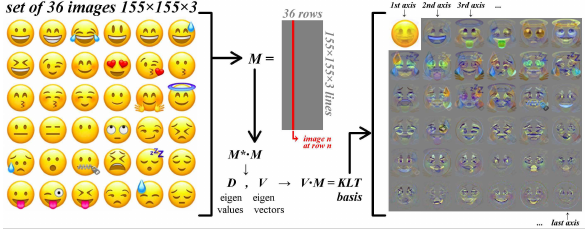
Figure 5: Karhunen-Lo`eve transform